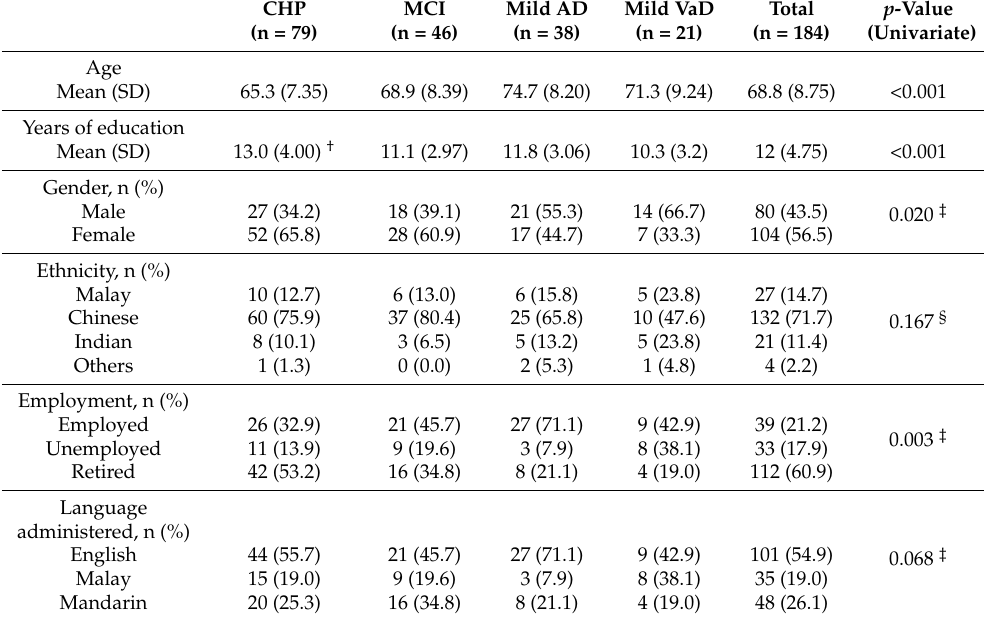
Table 2. Demographic characteristic of CHP, MCI, mild AD and mild VaD